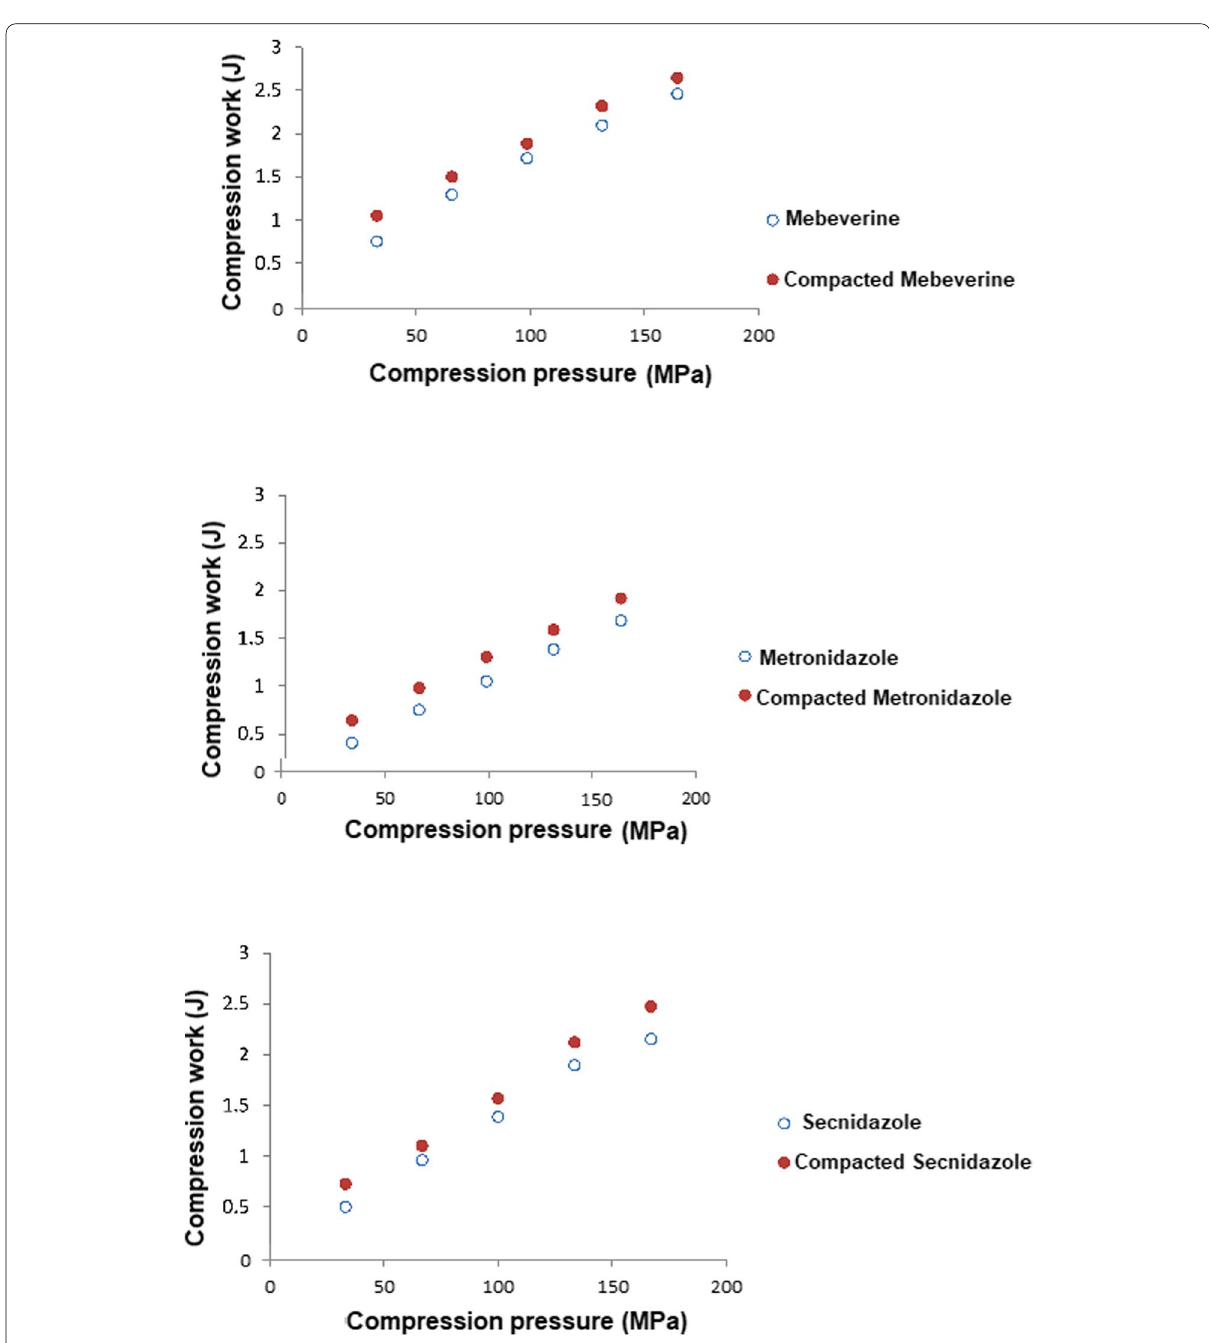
Fig. 4 The compression work, calculated based on the F-D curves, for non-compacted and compacted drugs comprising mebeverine, metronidazole, and secnidazole at different compression